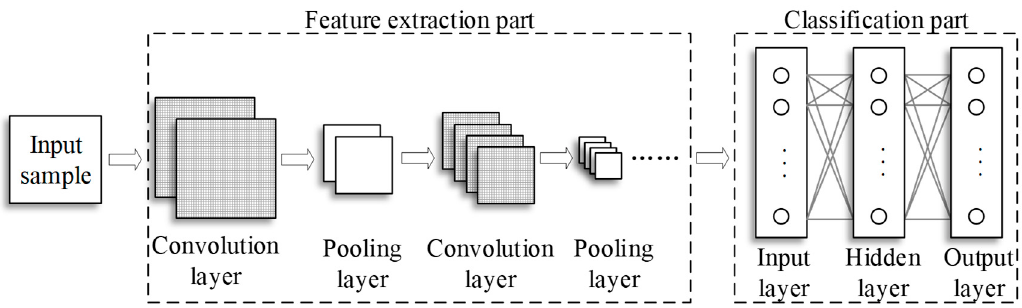
Figure 1. CNN structure.